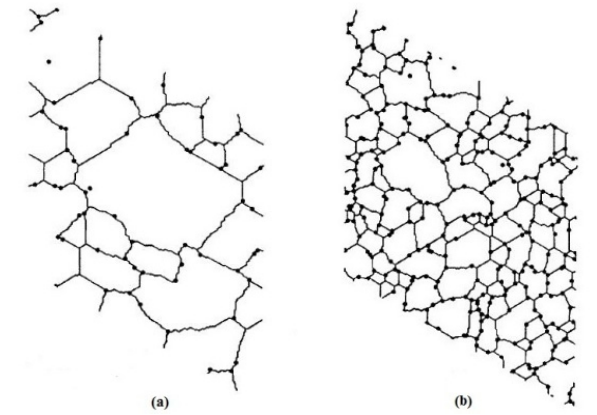
Figure 1. Pinned microstructures of nanocomposites for two volume fractions of particles of ( a ) V p = 0.01 and ( b ) V p = 0.05